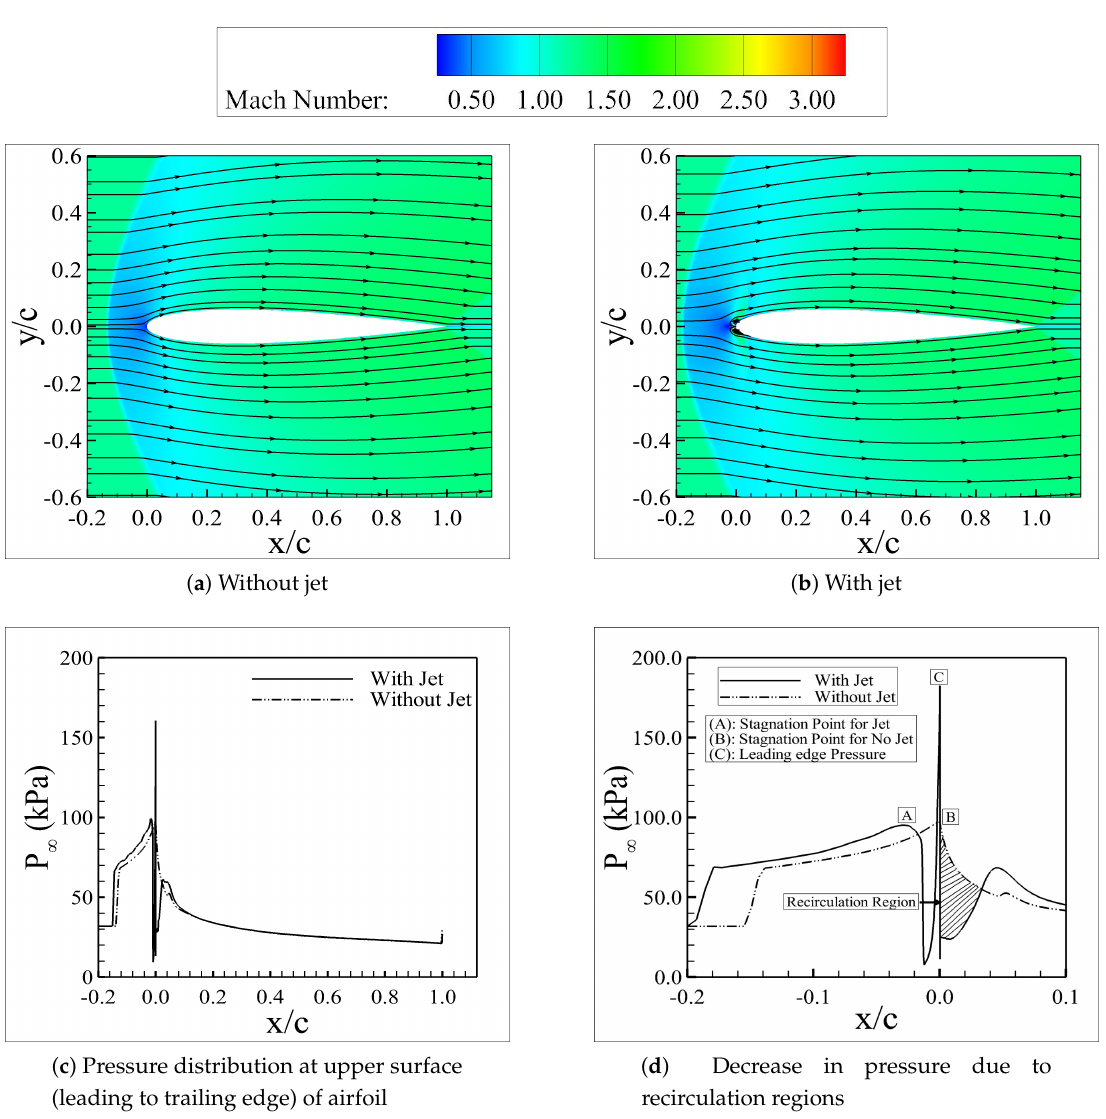
Figure 9. The comparison of drag reduction due to formation of recirculation